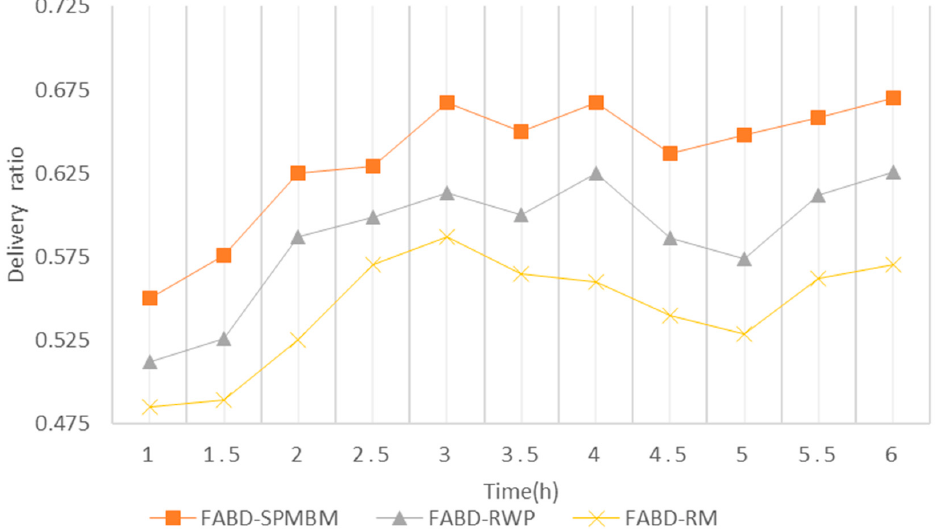
Figure 12. The receiving rate of the FABD algorithm in different mobile models.